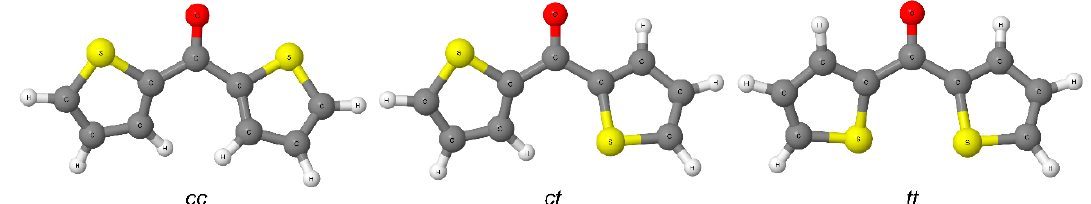
Figure 2. Three conformations of the investigated diheteroaryl ketones and thioketones. The B3LYP/def2-QZVPP-optimized conformers of 2a are shown as an example.